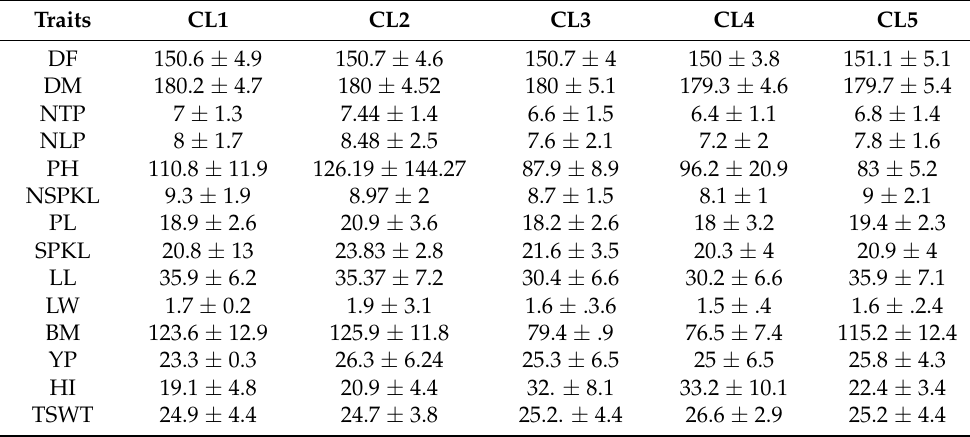
Table 5. Clustering mean based analysis of 100 genotypes of 14 quantitative traits of Oat ( Avena sativa ) for the year